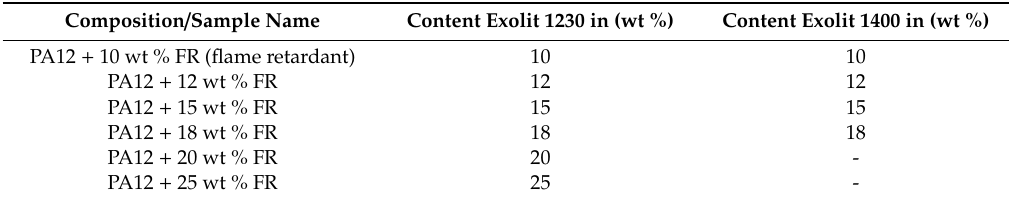
Table 1. Powder mixtures.